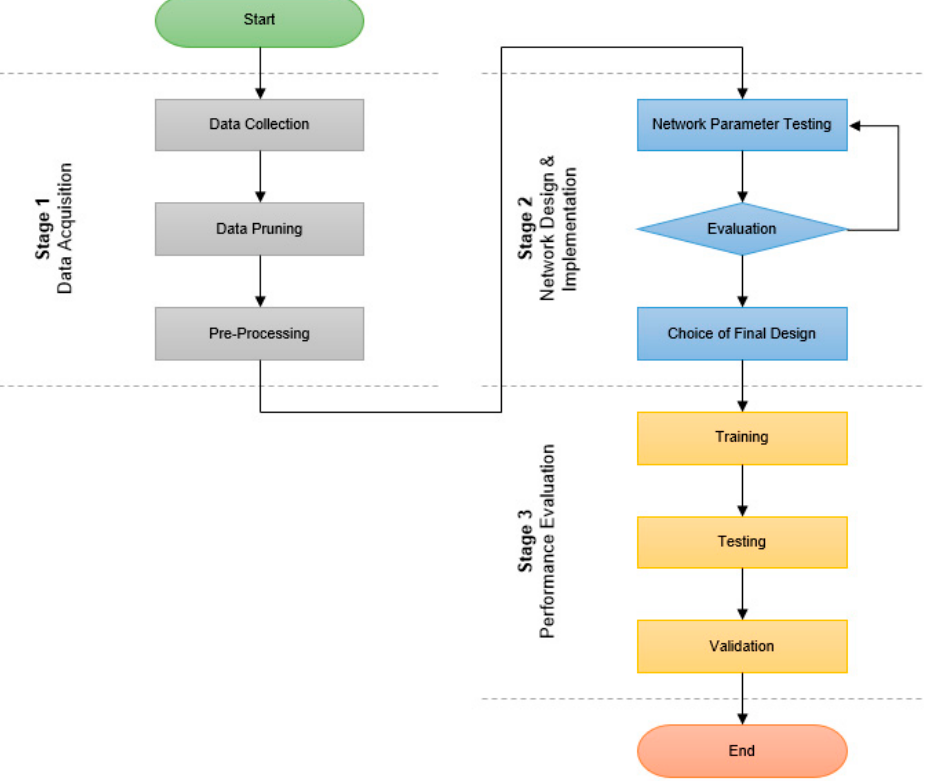
Figure 16. Flowchart: proposed systematic design approach.